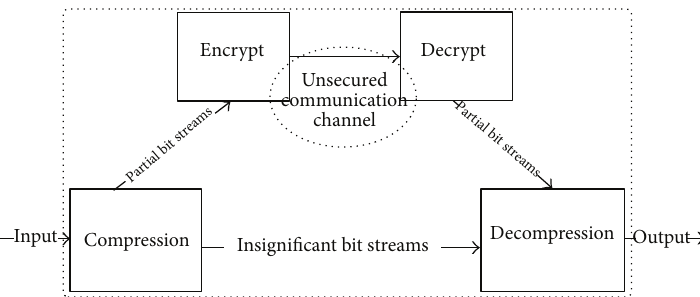
Figure 22: The overview of a selective encryption system (combination of an encryption and compression core).